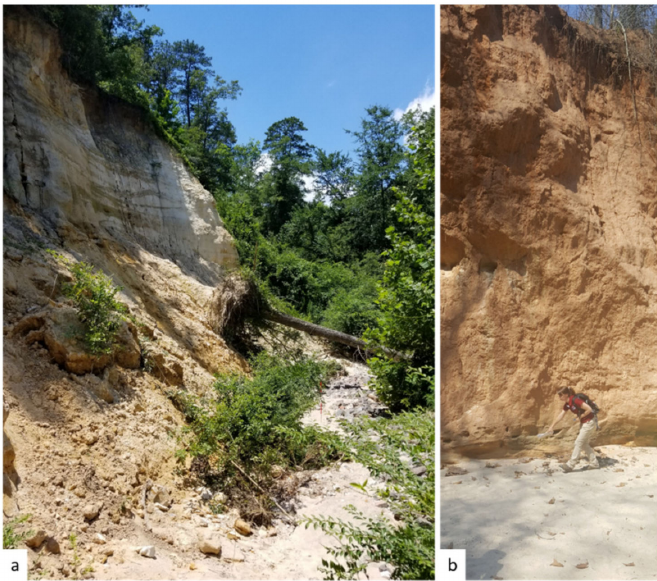
Figure 3. Photograph of the 3.05 m outfall pipe and gabion lined canal installed in 1992.